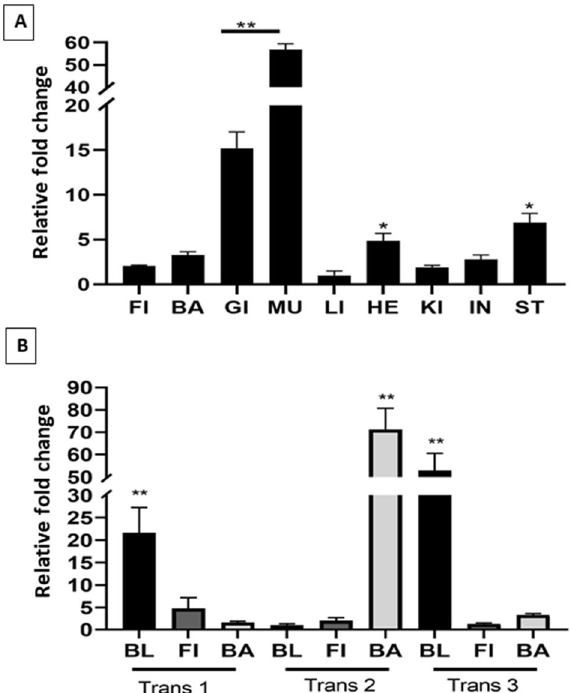
Figure 7. Relative expression profiles of the dsDNA-zebrafish ubiquitin-alligator cathelicidin construct in ( A ) different tissues and ( B ) tissues biopsied non-lethally from P 1 transgenic channel catfish ( Ictalurus punctatus ), as measured by qPCR. FI fin, BA barbel, GI gill, MU muscle, LI liver, HE heart, KI kidney, IN intestine, ST stomach, BL blood. Expression levels in ( A ) were calibrated against liver tissue which had the lowest expression level, and 18S rRNA gene was used as a reference gene. Trans 1, Trans 2, and Trans 3 were P 1 transgenic fish. Expression levels in ( B ) were calibrated against corresponding tissues from sibling non-transgenic control